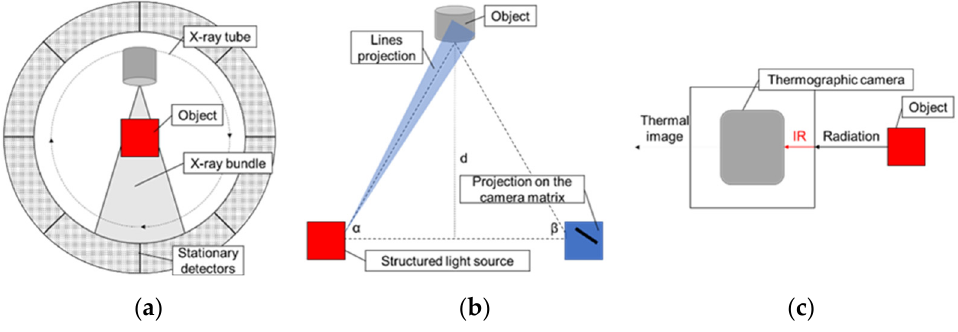
Figure 1. Scheme of the ( a ) CT, ( b ) 3D scanner and ( c ) IR camera.